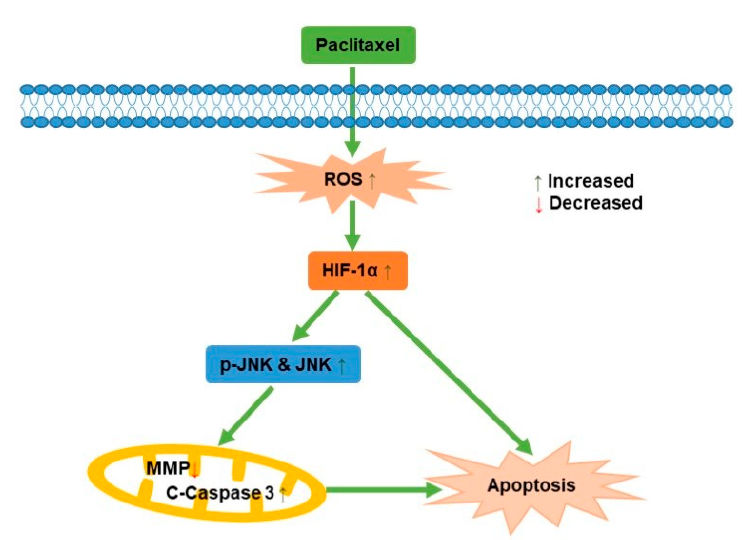
Figure 7. A schematic diagram for the role of paclitaxel on PC3M cell apoptosis.